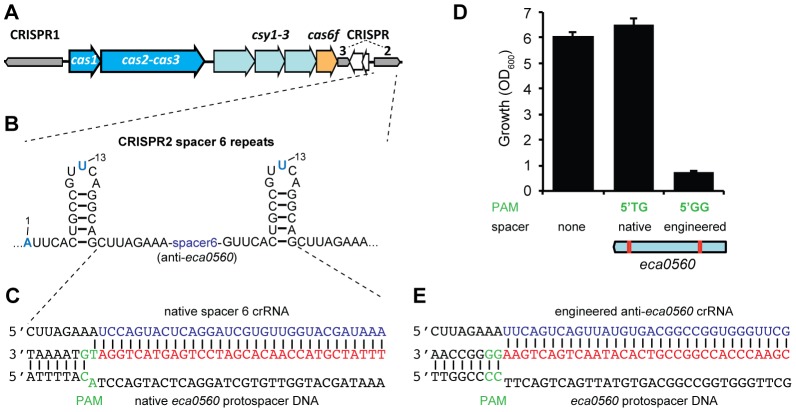
A single nucleotide PAM mutation enables escape from native CRISPR/Cas targeting.(A) P. atrosepticum CRISPR/Cas genomic organisation. The cas1 and the cas2-cas3 hybrid genes are shown in blue, csy1-3 in pale blue, cas6f in orange and the CRISPRs as grey arrows in the direction of transcription. CRISPR2 and 3 are separated by a toxin/antitoxin system (white arrows). (B) Spacer 6 of CRISPR2 (from leader) contains deviations from the repeat consensus (shown in blue) and (C) has a 100% match to a protospacer (red) within eca0560 in HAI2 in the P. atrosepticum genome. The protospacer matching spacer 6 contains a non-consensus 5′-protospacer-TG-3′ PAM (green). (D) Toxicity assays in the WT with plasmids containing consensus repeats and either no spacer (pC1-16), a single native spacer 6 (5′-protospacer-TG-3′ PAM; pTraGS6-16) or an engineered spacer (5′-protospacer-GG-3′ PAM; pTraG1-16) that targets eca0560. The protospacer locations in eca0560 of the native (pTraGS6-16) and engineered (pTraG1-16) spacers are shown below in red. (E) Sequence and pairing of the engineered anti-eca0560 spacer (in pTraG1-16) with the consensus 5′-protospacer-GG-3′ PAM (green).